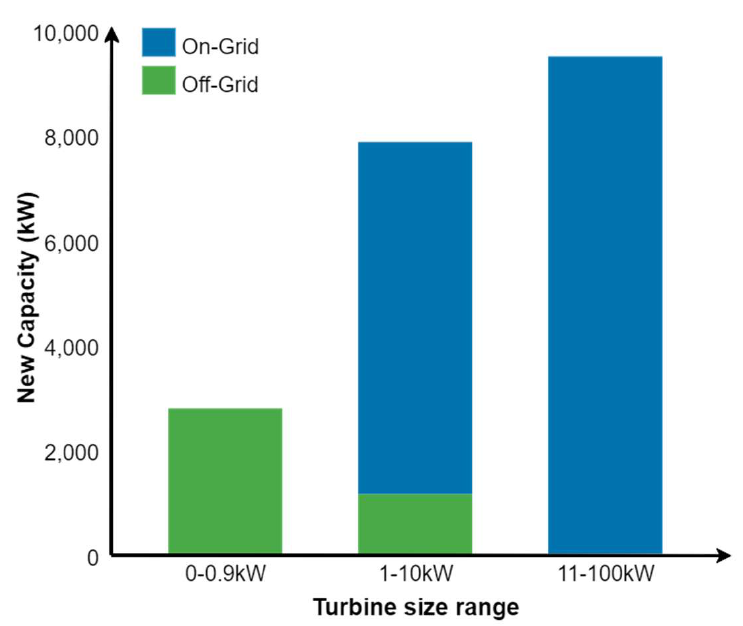
Figure 2. On- and off-grid capacity installed in the UK during 2012, as a function of SWT power range [4].